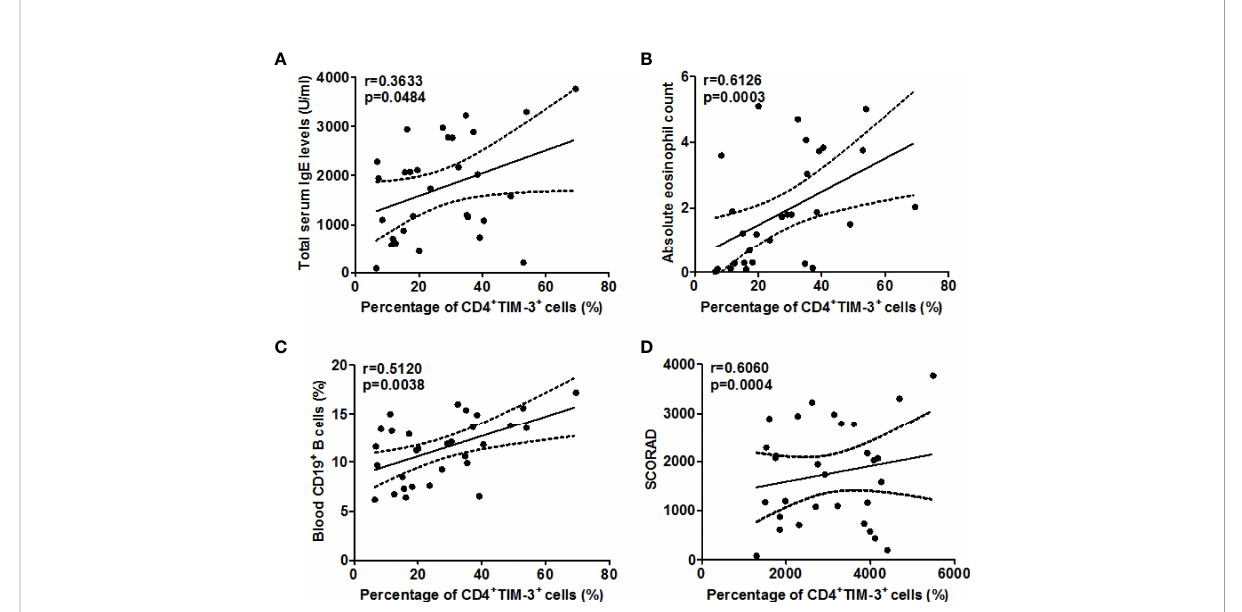
FIGURE 3 Association between the percentage of TIM-3 + CD4 + T cells and total serum IgE (A) , circulating eosinophils (B) , blood CD19 + B cells (C) , and disease activity as assessed by SCORAD (D) in patients with AD.